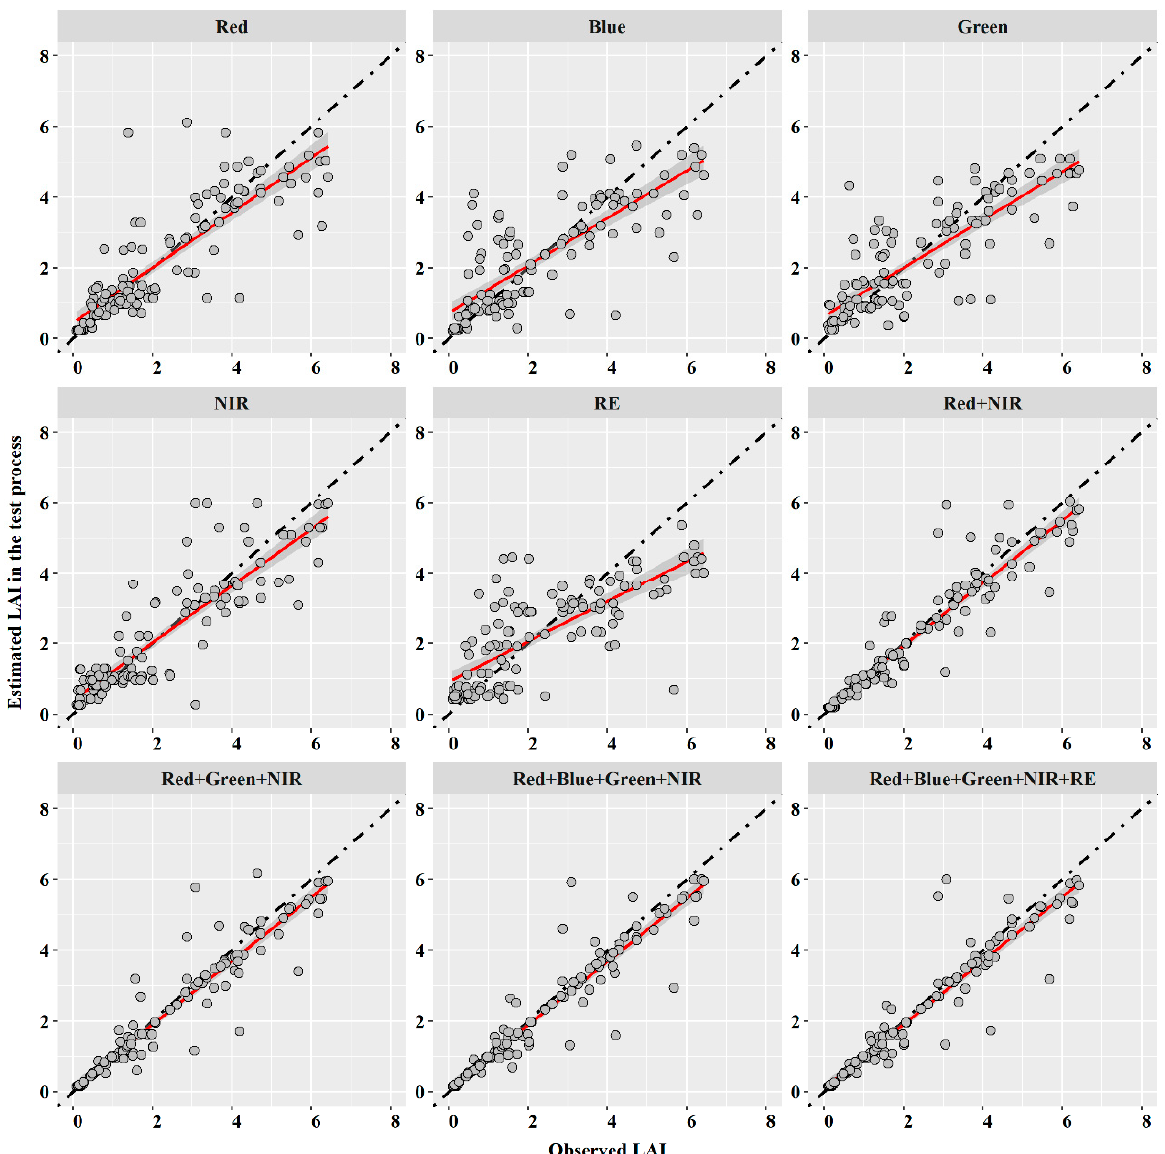
Figure 8. Relationship between observed and estimated leaf area index (LAI) of rice by Extreme Gradient Boosting model (XGBoost) with multispectral bands (B) in the test process. Dash lines and red solid lines are the 1:1 lines and the linear fitting lines, respectively. The shaded areas indicate the range of 95% prediction bands.